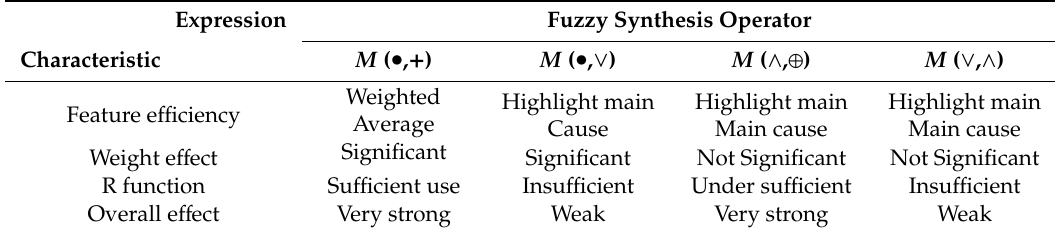
Table 1. Characteristics of fuzzy synthesis